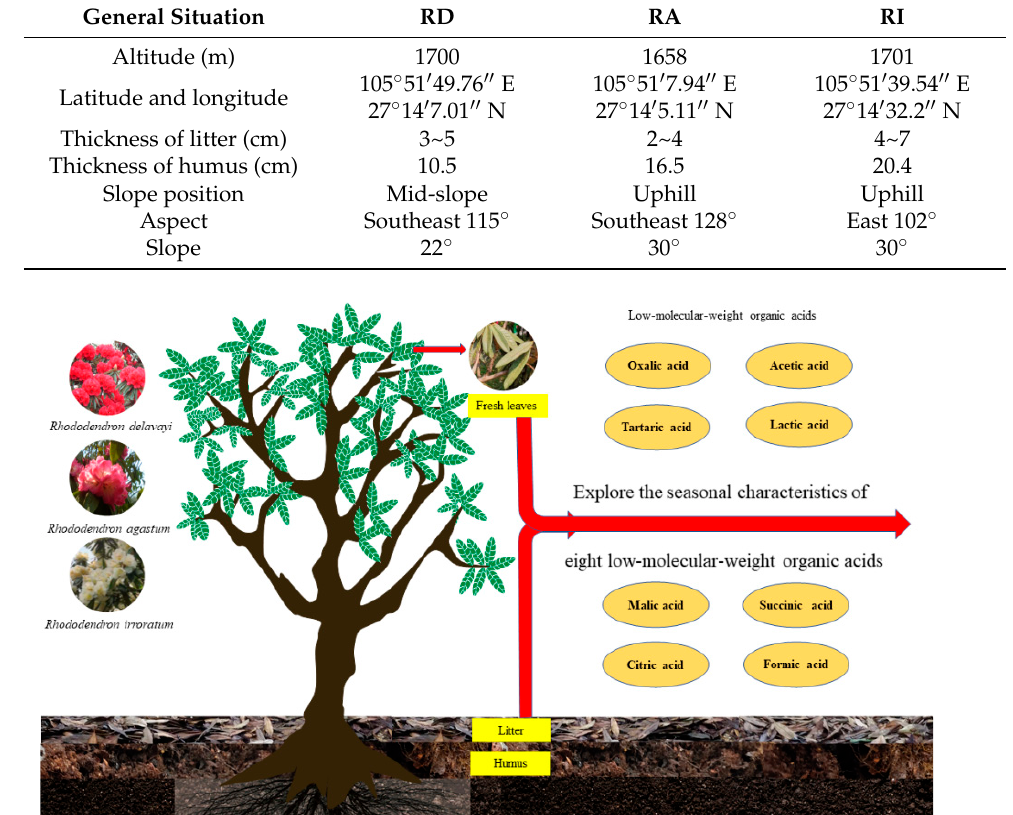
Table 1. Basic situation of the forest plots.